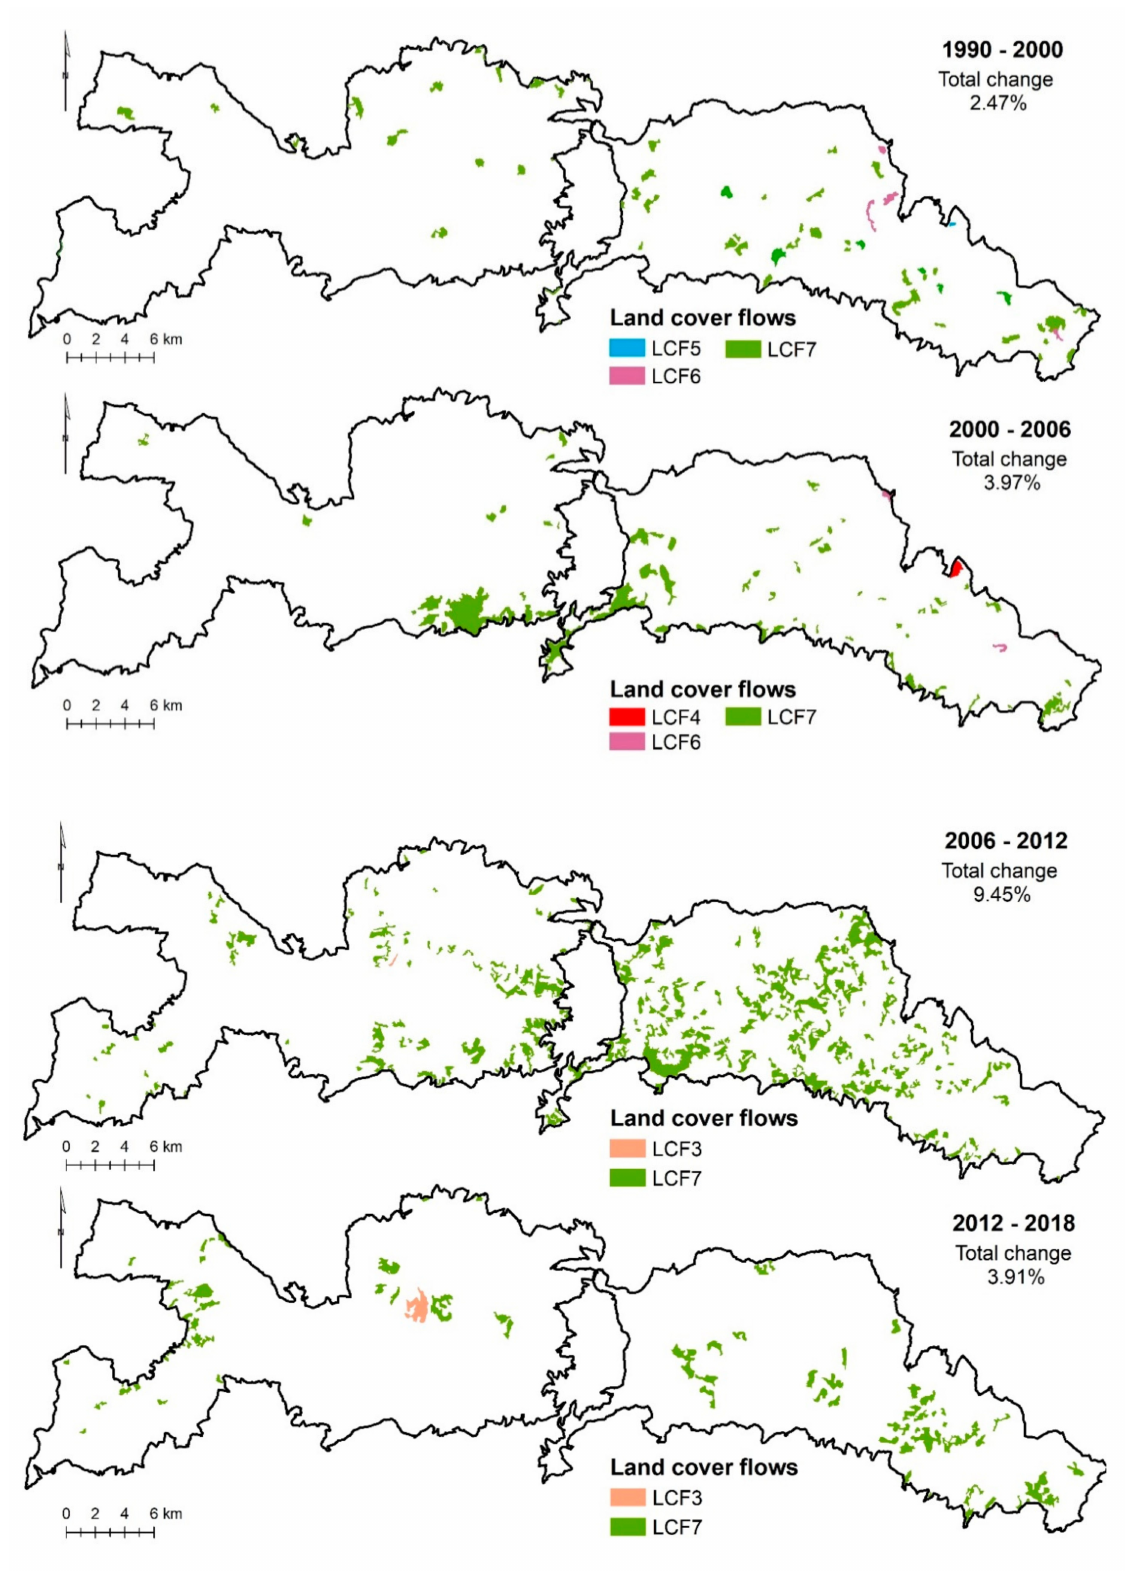
Figure 5. Land cover flows in Low Tatras National Park between 1990, 2000, 2006, 2012 and 2018. Relatively significant changes in the area extent of individual types of land cover have occurred on the timberline in the high mountain ranges of the Western Carpathians, including the Low